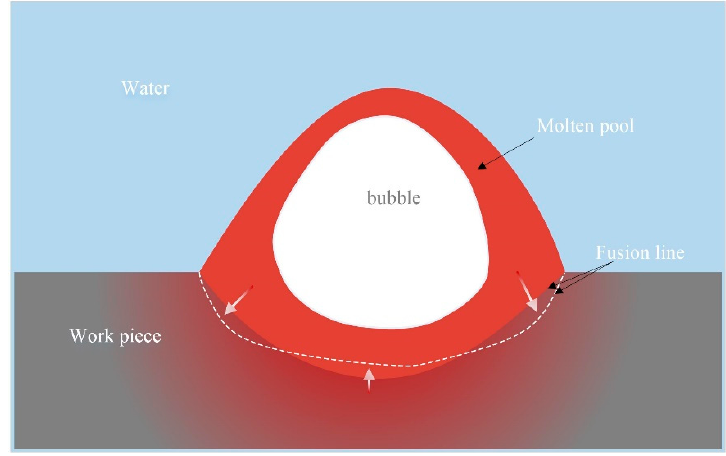
Figure 16. Schematic diagram of fusion line shape change.